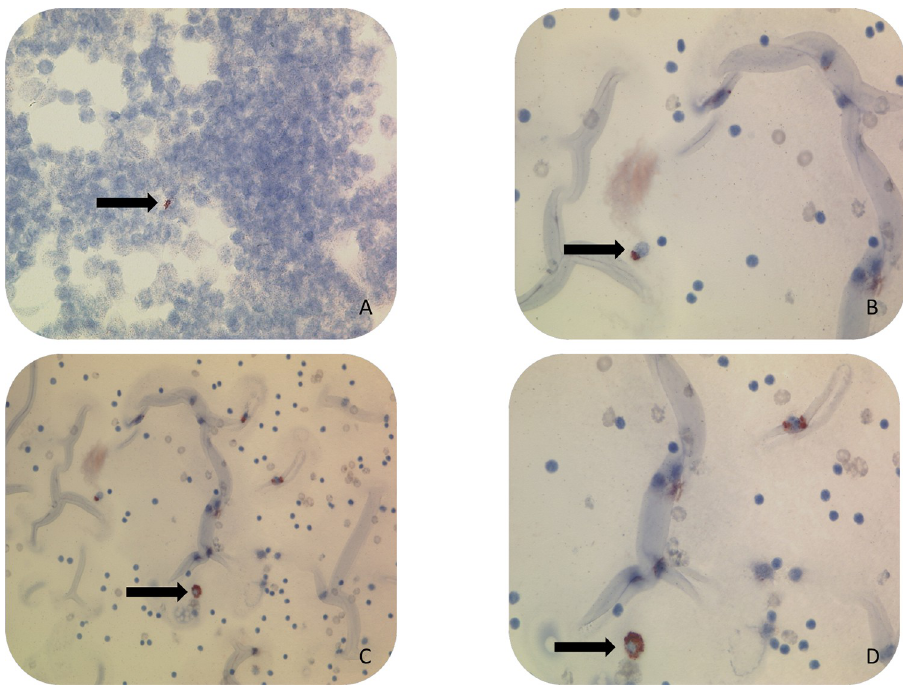
Fig 2. Immunostaining of cytological smears showing positive MPT64 staining as brown/red granular staining within macrophages (arrows). A: Lymph node (X40). The slide does not show clearly if the staining was inside a macrophage or in the background due to rupture of the macrophage. B: Cytological smear of pleural effusion showing positive signal for MPT64 (brown-red color) inside a macrophage (X40). C: Cytological smear of pleural effusion showing positive signal for MPT64 (brown-red color) inside macrophages (X20). D: Cytological smear of Pleural effusion showing positive signal for MPT64 (brown-red color) inside macrophages